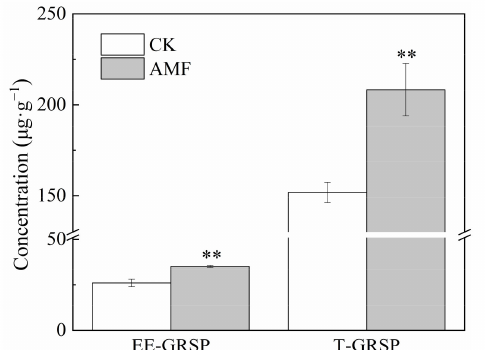
Figure 2. Effects of AMF on the content of EE-GRSP and T-GRSP under 20 mg · L − 1 Cd concentration stress. Error bar indicates standard deviation, n = 4. EE − GRSP represents easily extractable glomalin- related soil protein, T − GRSP represents total glomalin-related soil protein, CK represents the control of non-inoculation, Cd represents cadmium. AMF represents Funneliformis mosseae inoculation. “**” mean p < 0.01 according to LSD